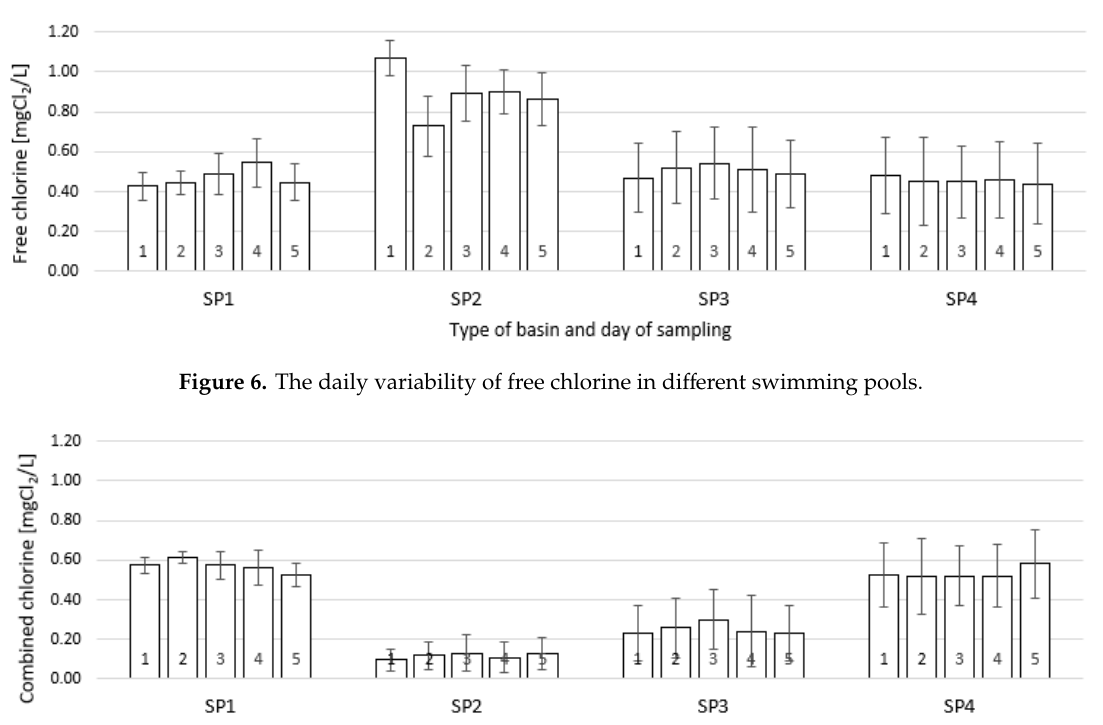
Figure 7. The daily variability of combined chlorine in different swimming pools.